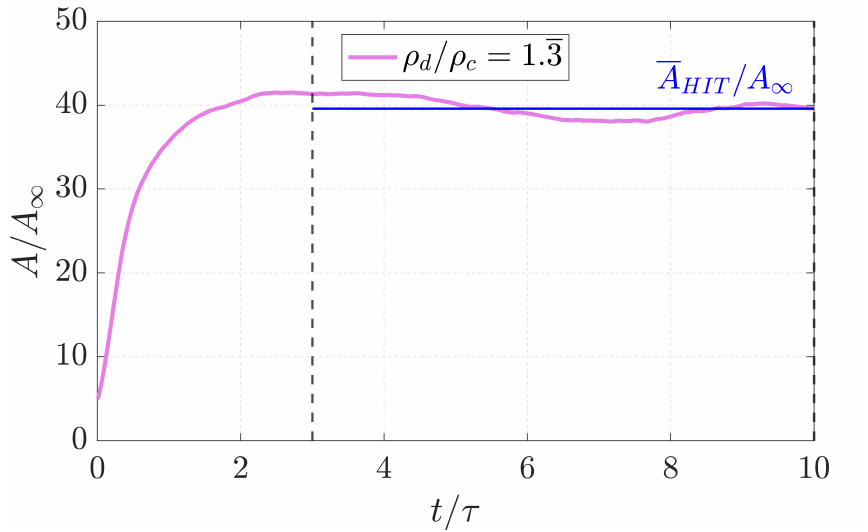
Figure 3. Evolution of the normalized interface area A / A ∞ , of the reference case, over the normalized time, t / τ . The first vertical line is the time at which the statistically stationary mixing state is reached. The horizontal line (blue) is the mean value of the normalized interface area A HIT / A ∞ , between t / τ = 3 and t / τ =